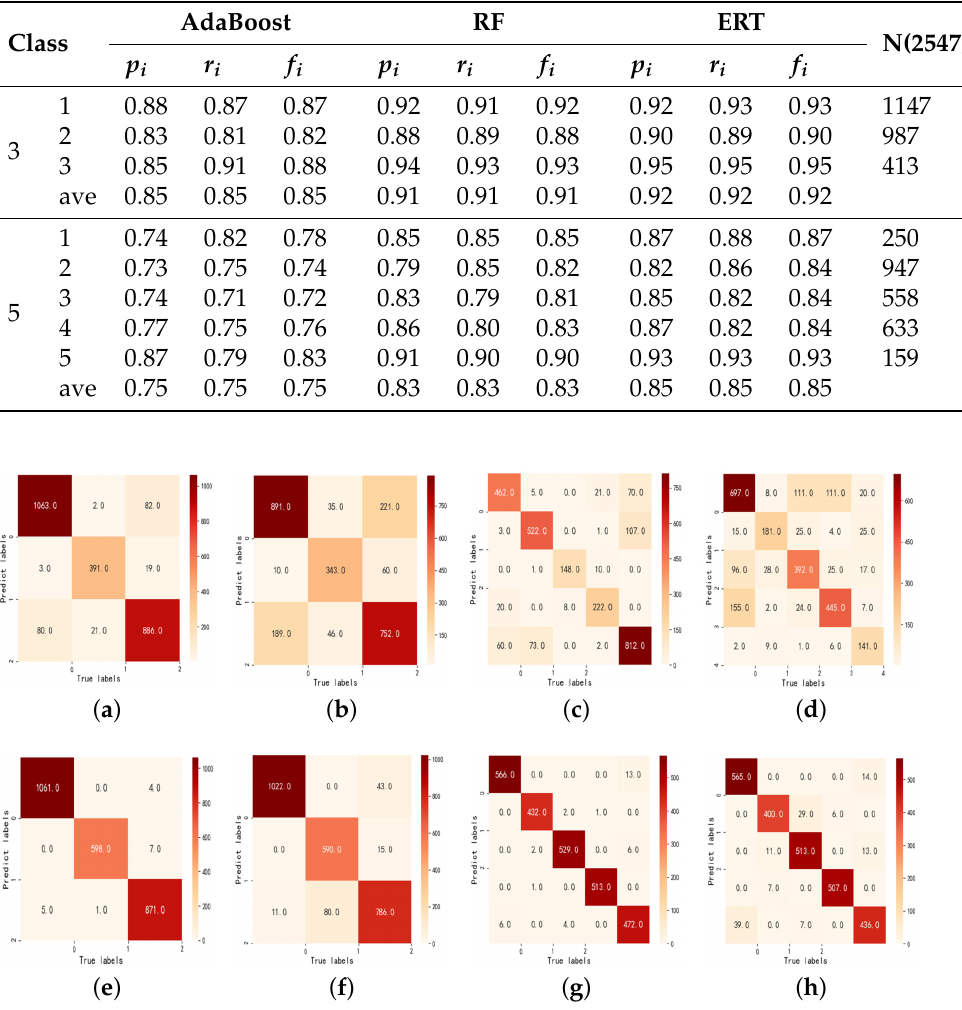
Figure 7. The confusion matrices of the ERT model under different cases (first row: torque; second row: thrust): ( a , e ) Input variables are in Raw form and output is into 3 classes; ( b , f ) Input variables are in HMM form and output is into 3 classes; ( c , g ) Input variables are in Raw form and output is into 5 classes; ( d , h ) Input variables are in HMM form and output is into 5